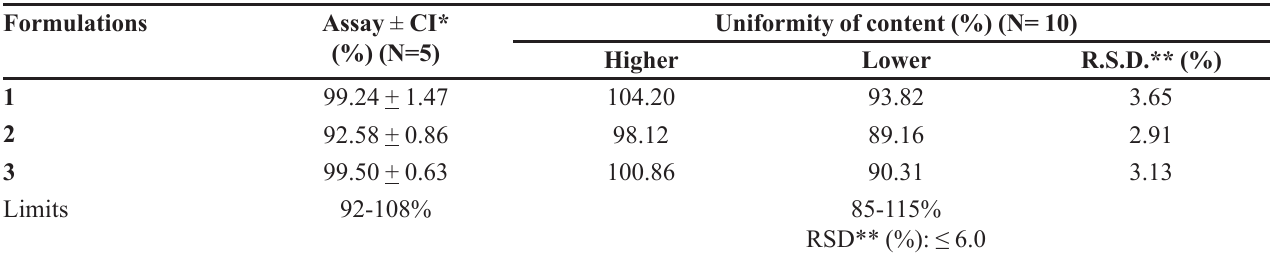
TABLE VI - Assay and uniformity of content of different formulations of OXC capsules